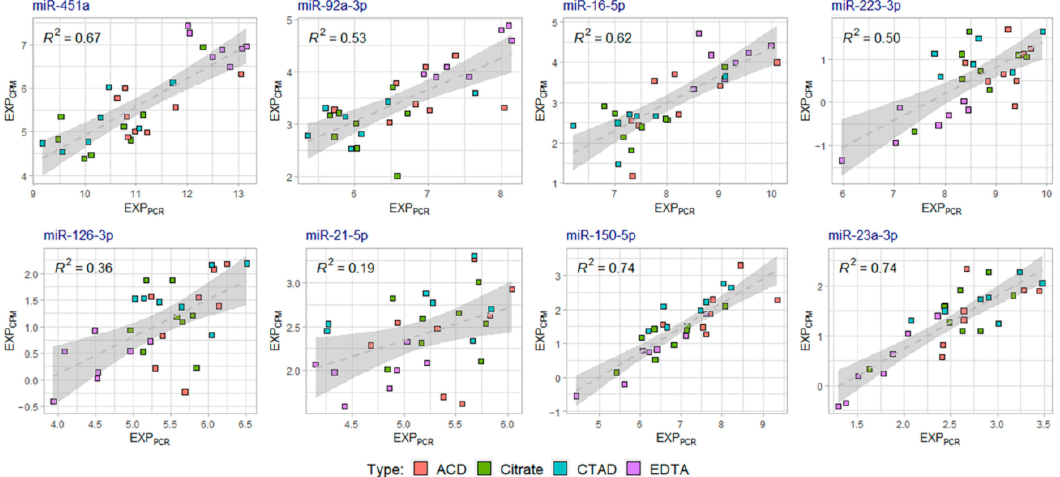
Figure 13. The concordance between qPCR-based and sequencing-based miRNA relative expression values within the 30 samples included in the miRNA sequencing analysis: mean EXP CPM values vs. mean EXP PCR values plot. EXP CPM values were calculated based on miRNA sequencing data as the difference between the mean log 2 CPM value of the analyzed miRNA and the mean log 2 CPM value of miR-30e-5p. EXP PCR values were calculated as qPCR-based miRNA plasma levels normalized to miR-30e-5p. The dots represent individual samples included in the analysis, the dotted line represents a trend line for a linear regression and the gray areas correspond to the 95% confidence interval. For each plot, R-squared ( R 2 ) values for the linear regression are given. R 2 values indicate the proportion of the variance for a dependent variable ( y -axis) that is explained by an independent variable ( x -axis).